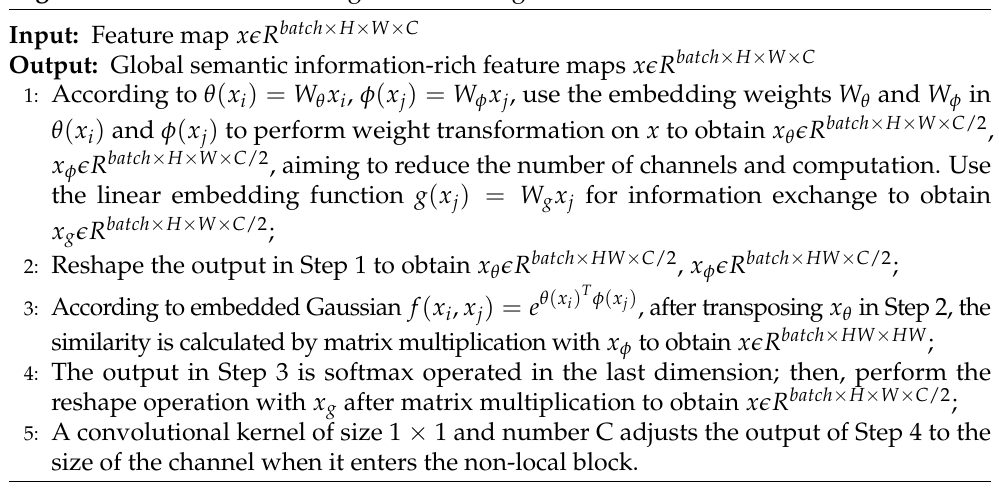
Algorithm 1 Transformation algorithm in the global feature extraction module